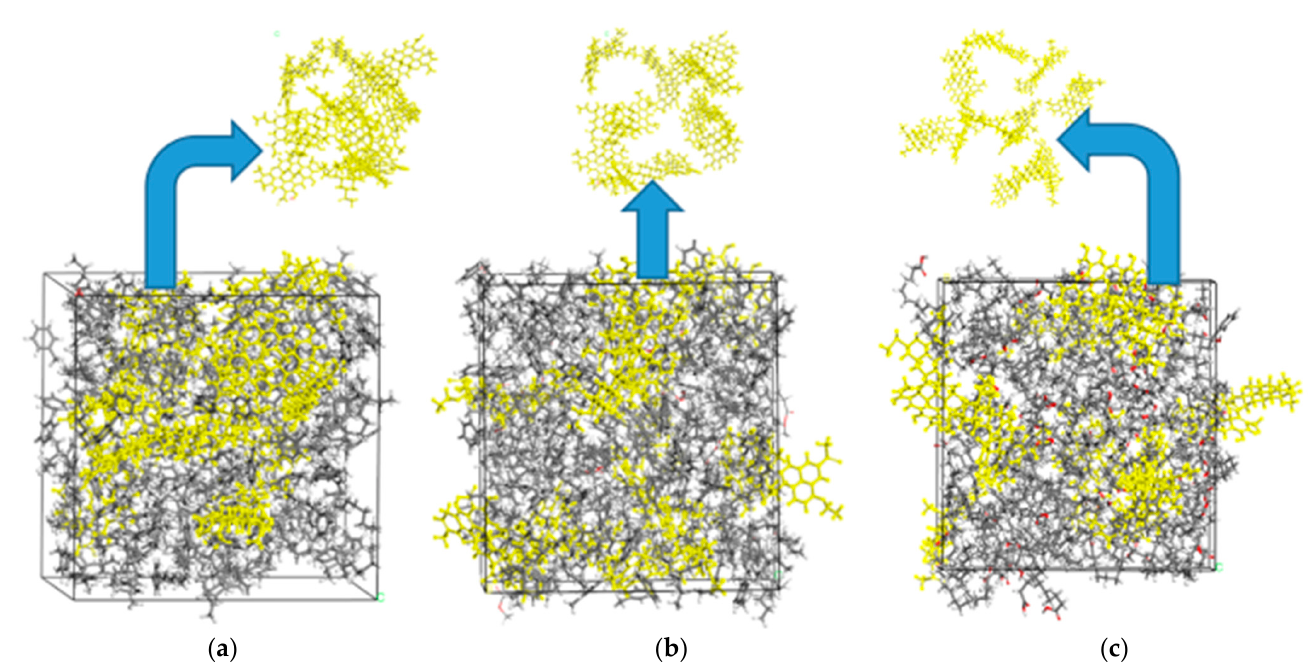
Figure 9. Equilibrium structure of ( a ) asphaltene in model oil ( b ) asphaltene in model oil in the presence of biodiesel ( c ) asphaltene in model oil in the presence of oleic acid (Yellow is asphaltene).